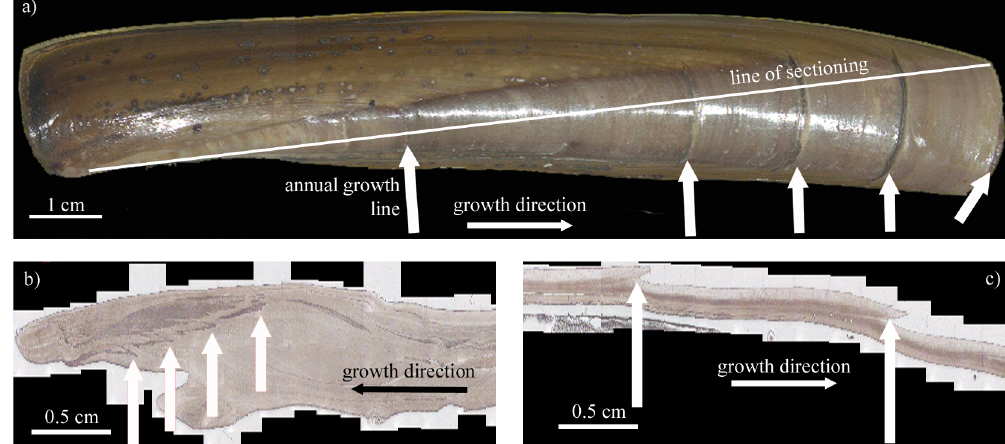
Fig. 1. Photographs of valve and cross sections of E. directus shells: (a) valve with lines identified externally as annual growth lines (arrows), (b) acetate peel of the hinge showing internal annual growth lines, and (c) acetate peel of the valve with two annual growth